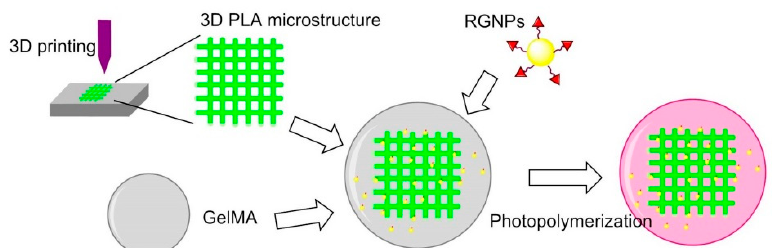
Figure 14. 3D printing for surface functionalization. 3D PLA microstructure was prepared via 3D printing technology; GelMA was obtained by methacrylation of gelatin; peptide-conjugated Gold NPs (RGNPs) were prepared by reduction of chloroauric acid before conjugating RGD peptides.